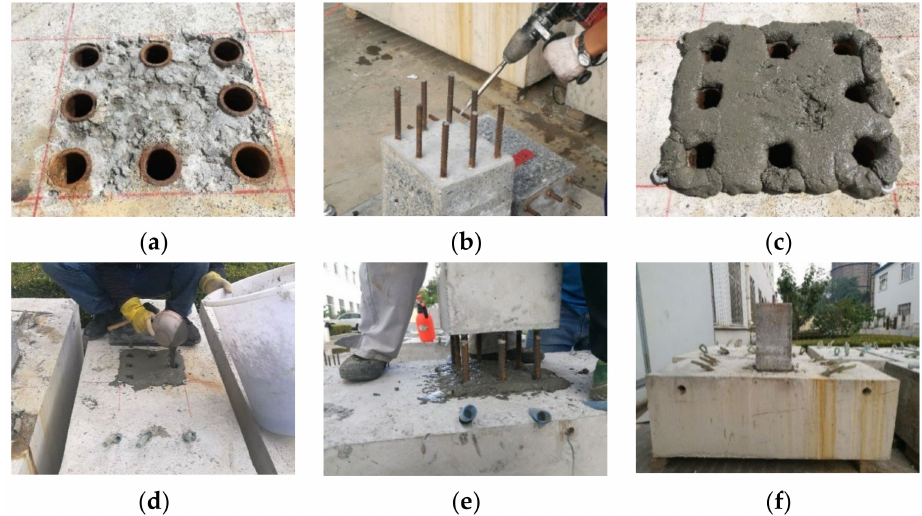
Figure 19. The main process of assembly. ( a ) Base cut hair. ( b ) Roughening of the F-T segment. ( c ) Laying the sealing material. ( d ) Artificial grouting. ( e ) Inserting freeze–thaw segments. ( f ) End of the assembly.